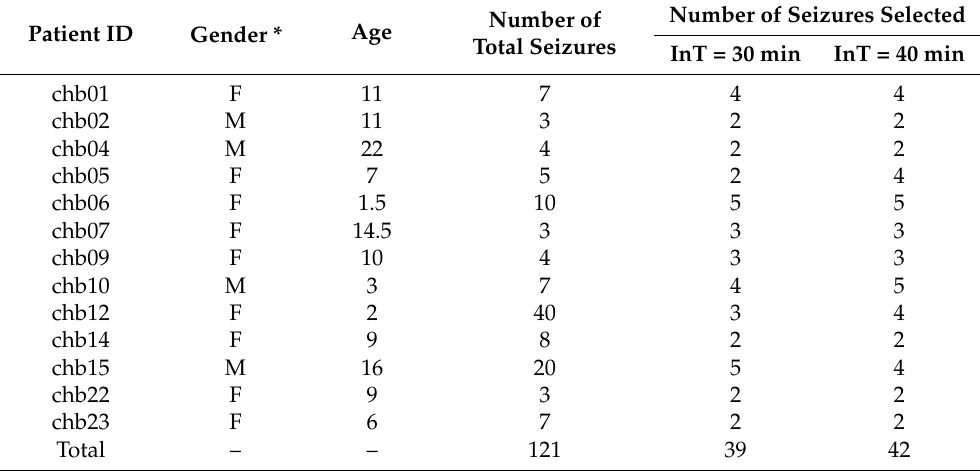
Table 1. Details of selected